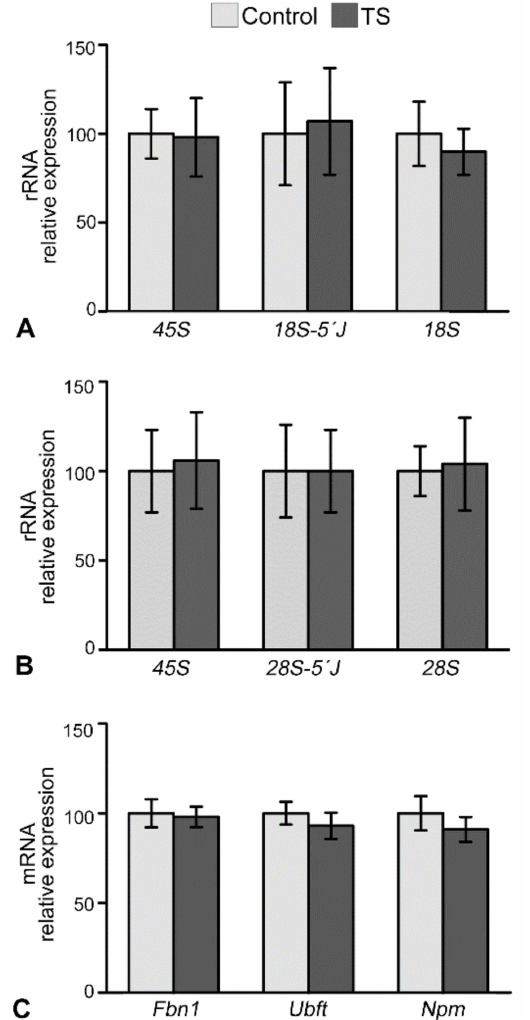
Figure 4. Ribosomal and nucleolar proteins genes expression is preserved in the GCs of TS mice . ( A , B ) RT-qPCR of the expression levels of pre-rRNA 45S, 18S 5 (cid:48) and 28S 5 (cid:48) junction precursors and mature 18S and 28S rRNAs in hippocampal RNA extracts from control and TS mice. Non- significant changes in all studied categories of rRNAs were detected in TS mice as compared to wild-type. ( C ) Expression levels of Ubtf, Npm1, and Fbn1 mRNAs encoding three key nucleolar proteins, UBF, nucleophosmin, and fibrillarin. Non-significant differences between control and TS samples were observed in the three mRNAs analyzed. Data is presented as means + SEM of three independent